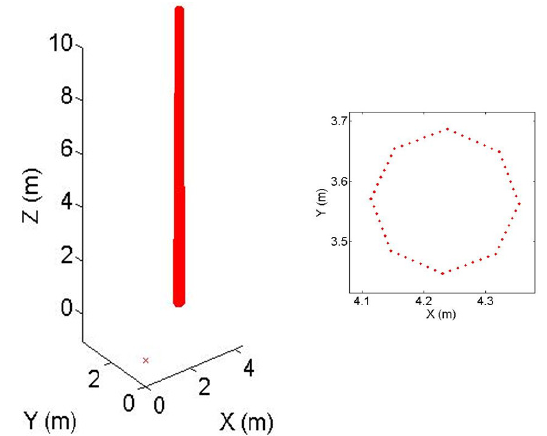
Figure 5. The simulated octagonal lamp pole (5a, left) and its projected cross section on the XY -plane (5b, right) Table 1. The parameter values for the simulated octagonal pole